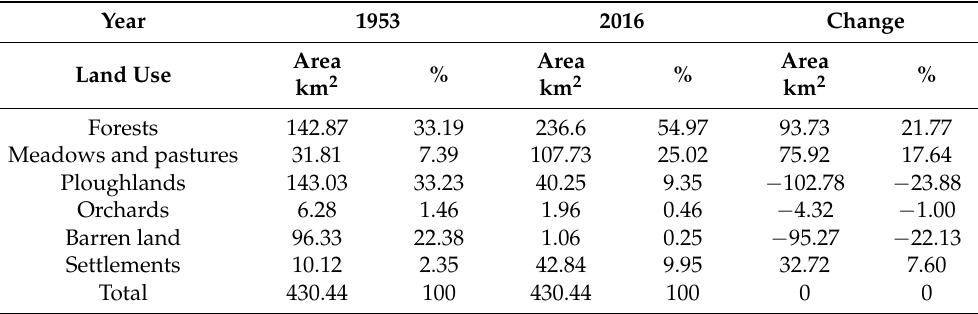
Table 5. Land use in Grdelica Gorge in 1953 [38] and 2016.